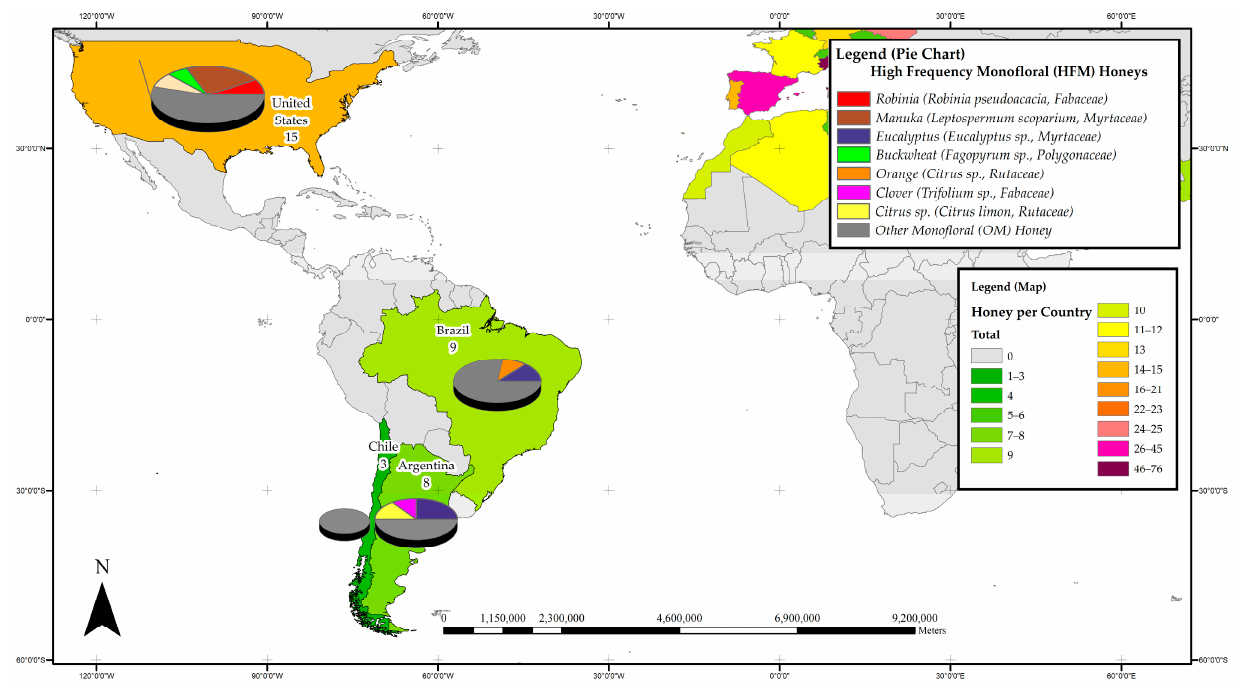
Figure 3. Most frequently studied honeys with respect to their phenolic profile in Asia.